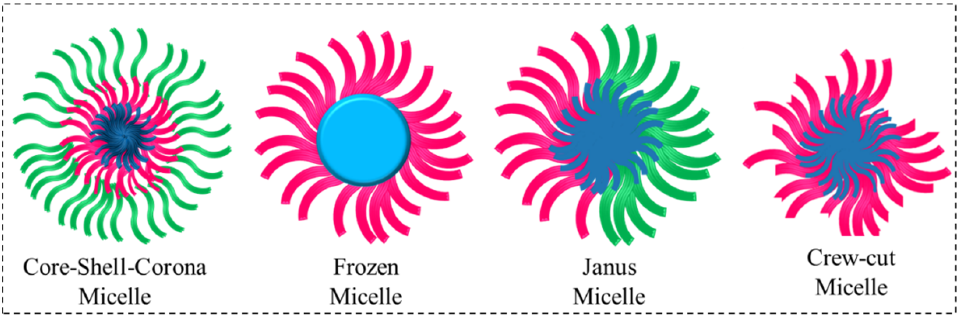
Figure 7. Various form of polymeric micelles from different blocks.